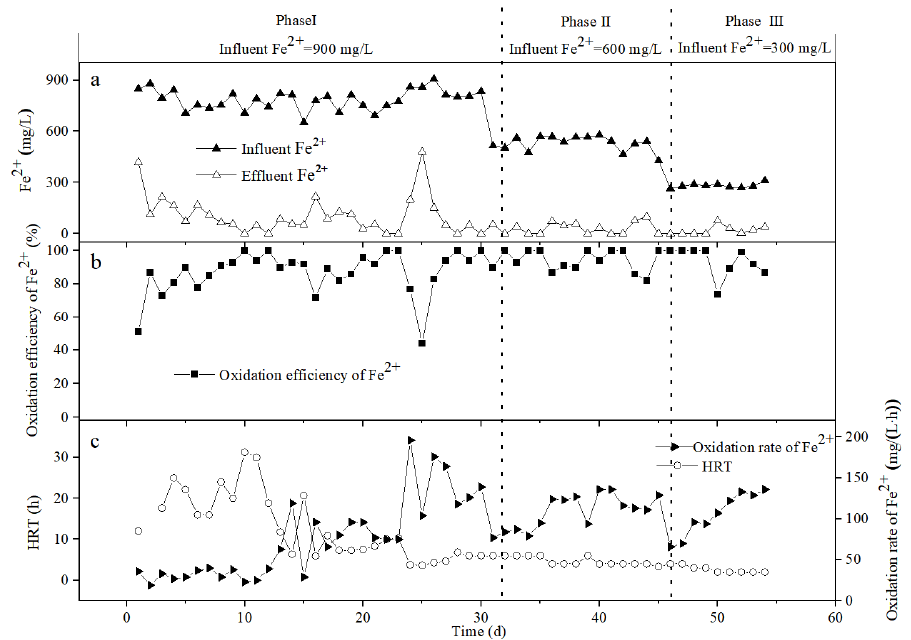
Figure 6. Variation of the Fe 2+ concentration ( a ), Fe 2+ oxidation efficiency ( b ), Fe 2+ oxidation rate, and HRT ( c ) in the influent and effluent of the bio-activated carbon packed column.